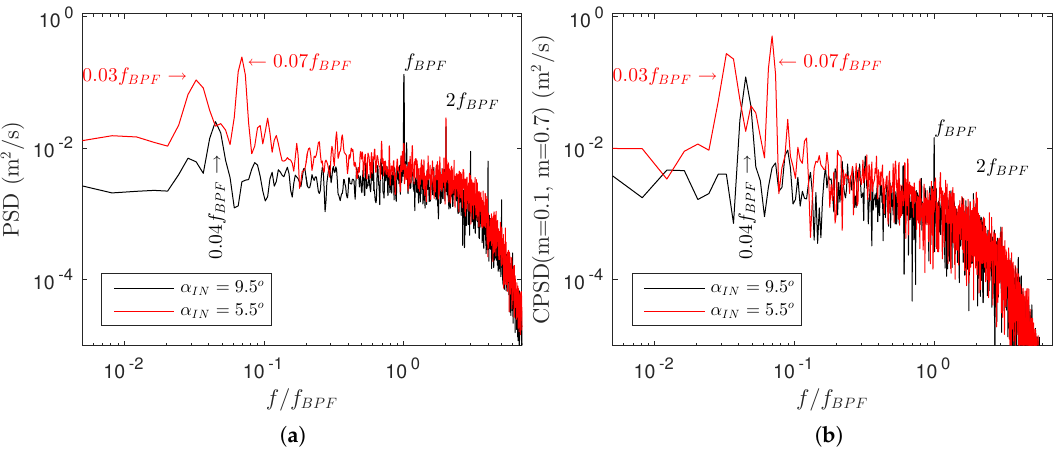
Figure 7. ( a ) Power spectral density of the tangential velocity component in a probe point located at m = 0.1 in the mid of the diffuser channel n = 0.5. Data is compared for the two different flow angles considered. ( b ) Cross power spectral density of the tangential velocity component between probe points located at m = 0.1 and m = 0.7 in the mid of the diffuser channel n = 0.5. Data is for the two flow angle case